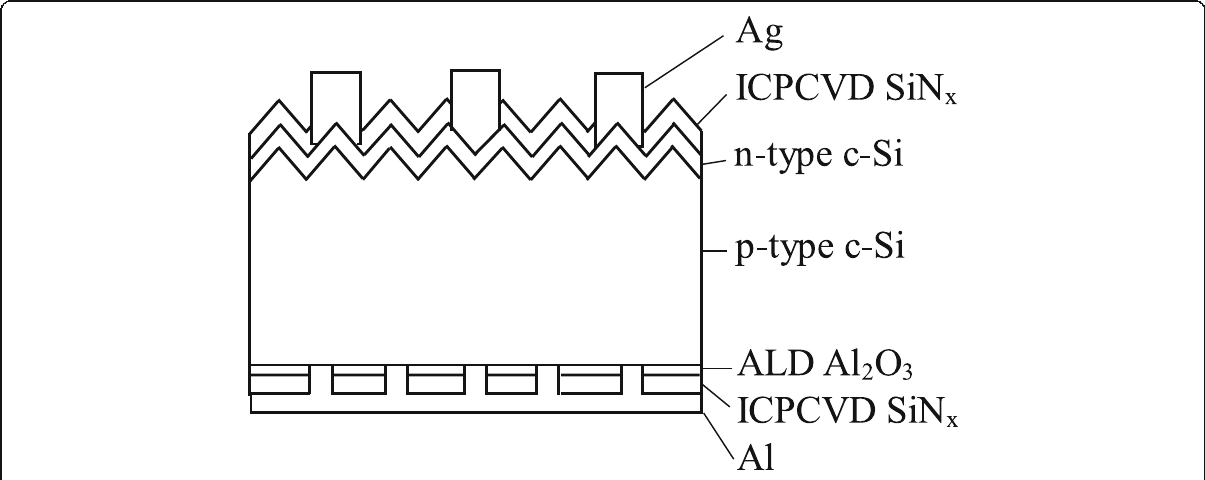
Fig. 1 Schematic of PERC solar cells with SiN x /ALD Al 2 O 3 rear passivation